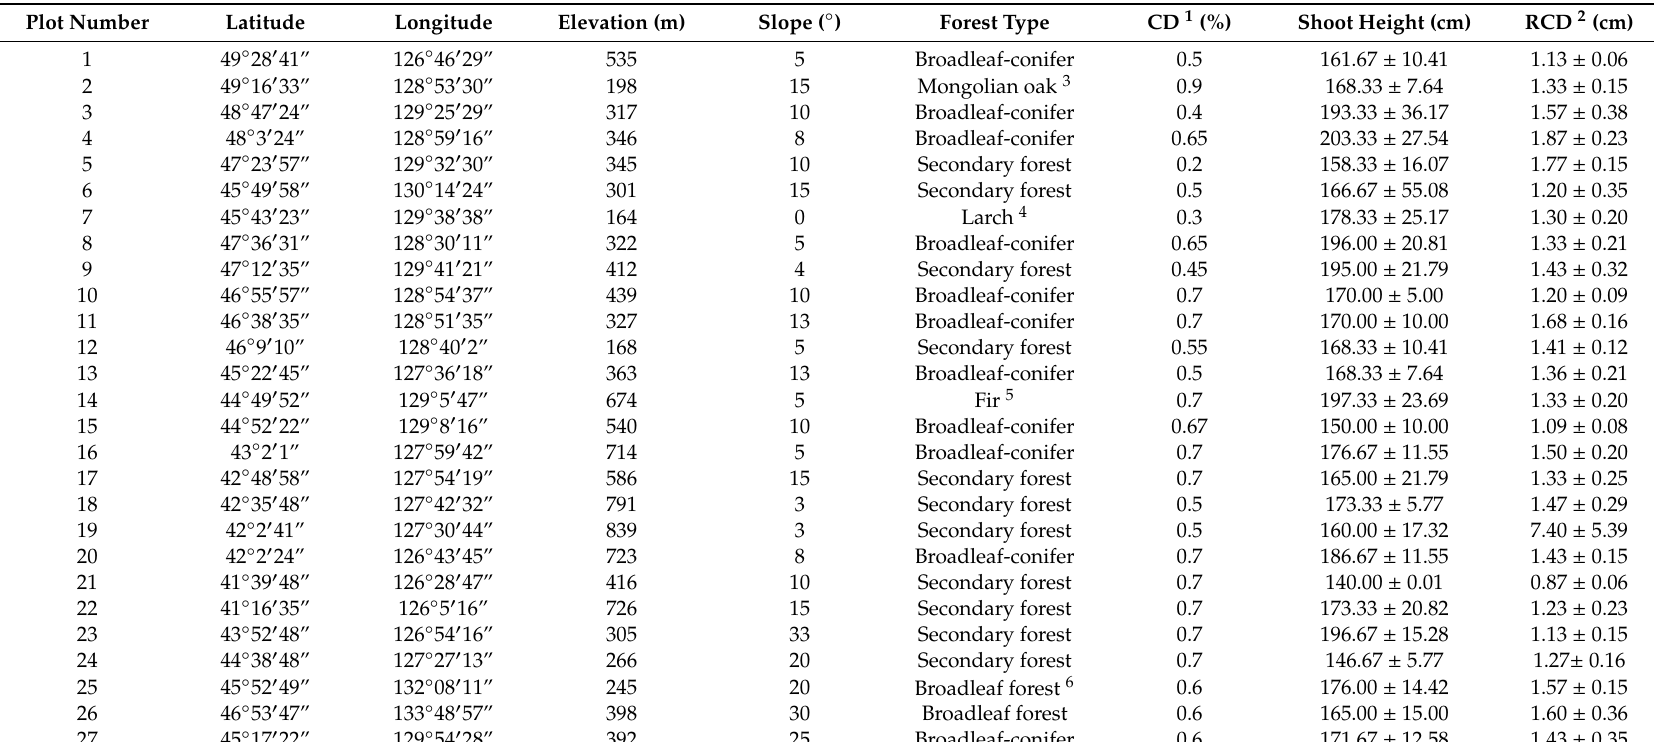
Table 1. Plot characteristics of natural Acanthopanax senticosus populations in forests in Northeast